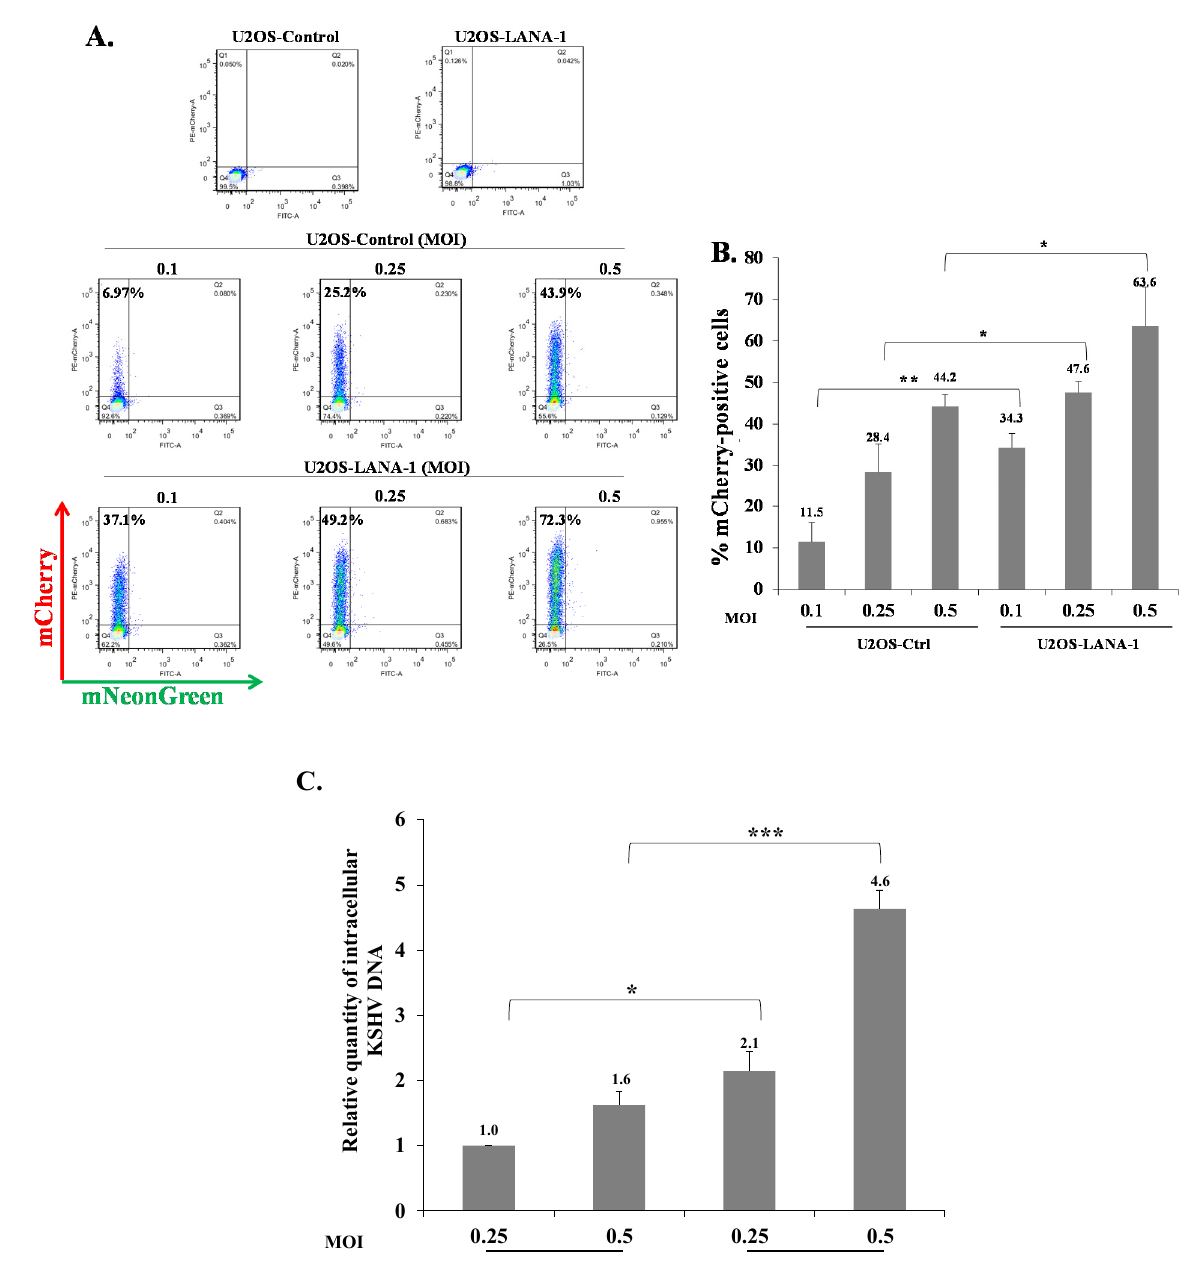
Figure 11. Role of LANA-1 in enhancing latency in U2OS cells. ( A ) U2OS-Control and U2OS-LANA-1 cells were treated with doxycycline (1 µg/mL), and after 24 h the cells were infected with BAC16-mCherry virus at an MOI of 0.1, 0.25, and 0.5 using spinoculation. Cells were harvested 48 h post infection and the percentages of cells expressing mCherry were measured by FACS. ( B ) Percentage of cells expressing mCherry obtained following infection based on the average of three independent experiments. Statistical analysis was performed using the One-way ANOVA test and Tukey’s post hoc analysis. * p < 0.05, ** p < 0.01. ( C ) TaqMan real-time quantitative PCR was performed as described in Figure 7. DNA levels are shown relative to U2OS-control cells that were infected with BAC16-mCherry virus at an MOI of 0.25, which was normalized to 1. Results presented are from three independent experiments. Statistical analysis was performed using the ANOVA test and t -test. ** p < 0.01, *** p < 0.001.